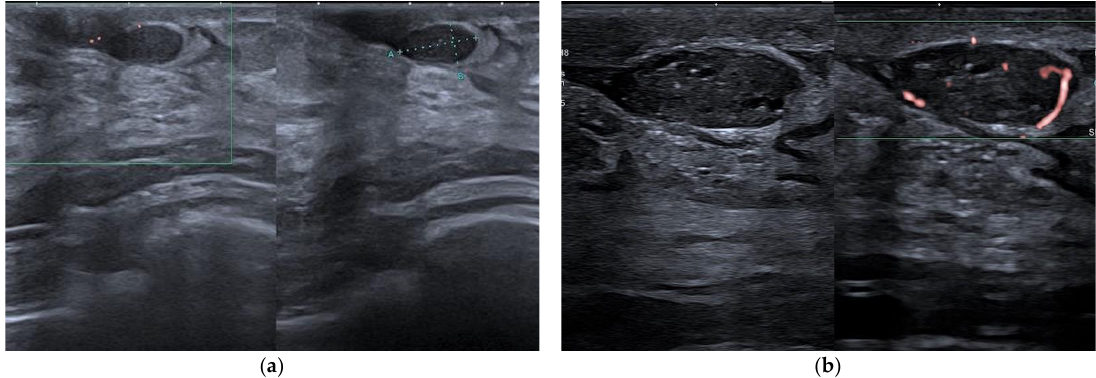
Figure 6. Intraductal papilloma. Retroareolar, oval hypoechoic nodule without flow signals (8 × 4 mm). Appearance at 15 MHz ( a ). When imaged at 22 MHz ( b ), the lesion is clearly located in the lumen of a duct and exhibits some internal vessels under power-Doppler